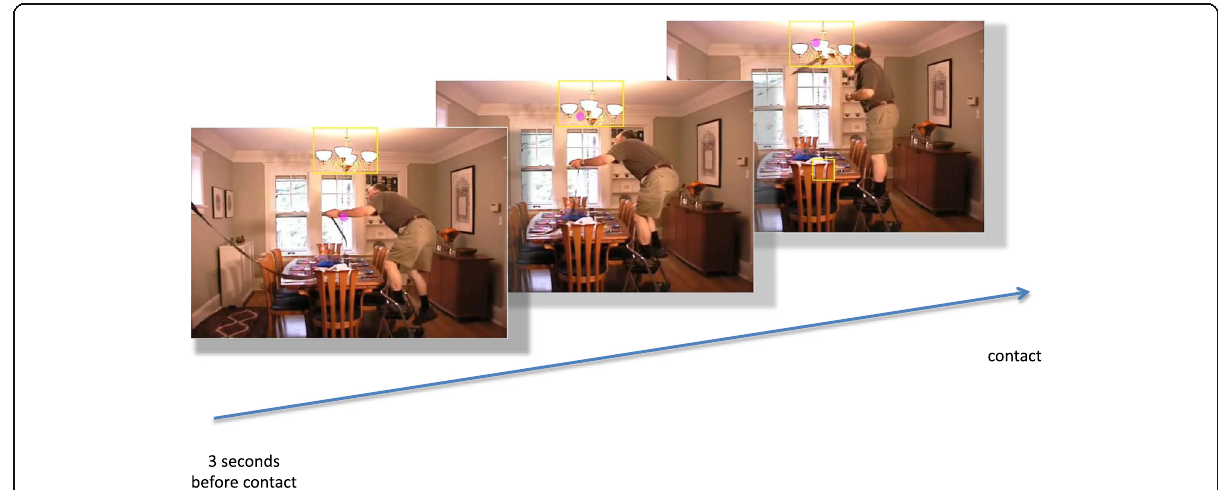
Fig. 1 Three example frames taken from one of the movies used in Study 2. The first frame is taken from around three seconds before the actor contacted the chandelier and the third frame is taken from around the time the actor contacted the chandelier. The yellow box represents the interest area, which was drawn around the chandelier — the object the actor was about to contact in order to hang a streamer. The purple dot represents the gaze location of one participant. Here, the participant looked at the chandelier before the actor contacted it. (Participants did not see the yellow box or their own gaze location while performing the